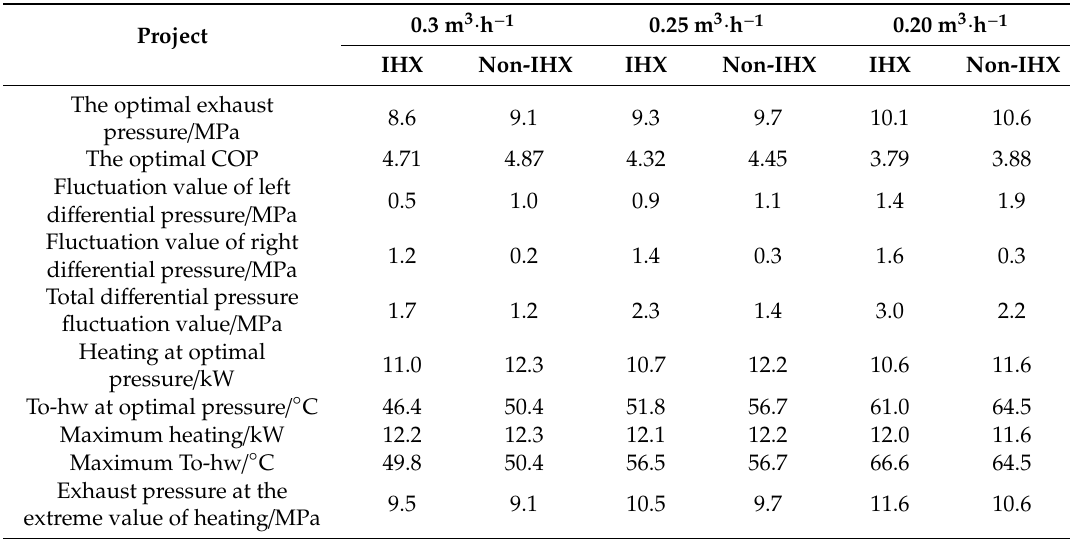
Table 4. Comparison of main performance parameters of HPWHs with and without IHX at di ff erent hot water inlet